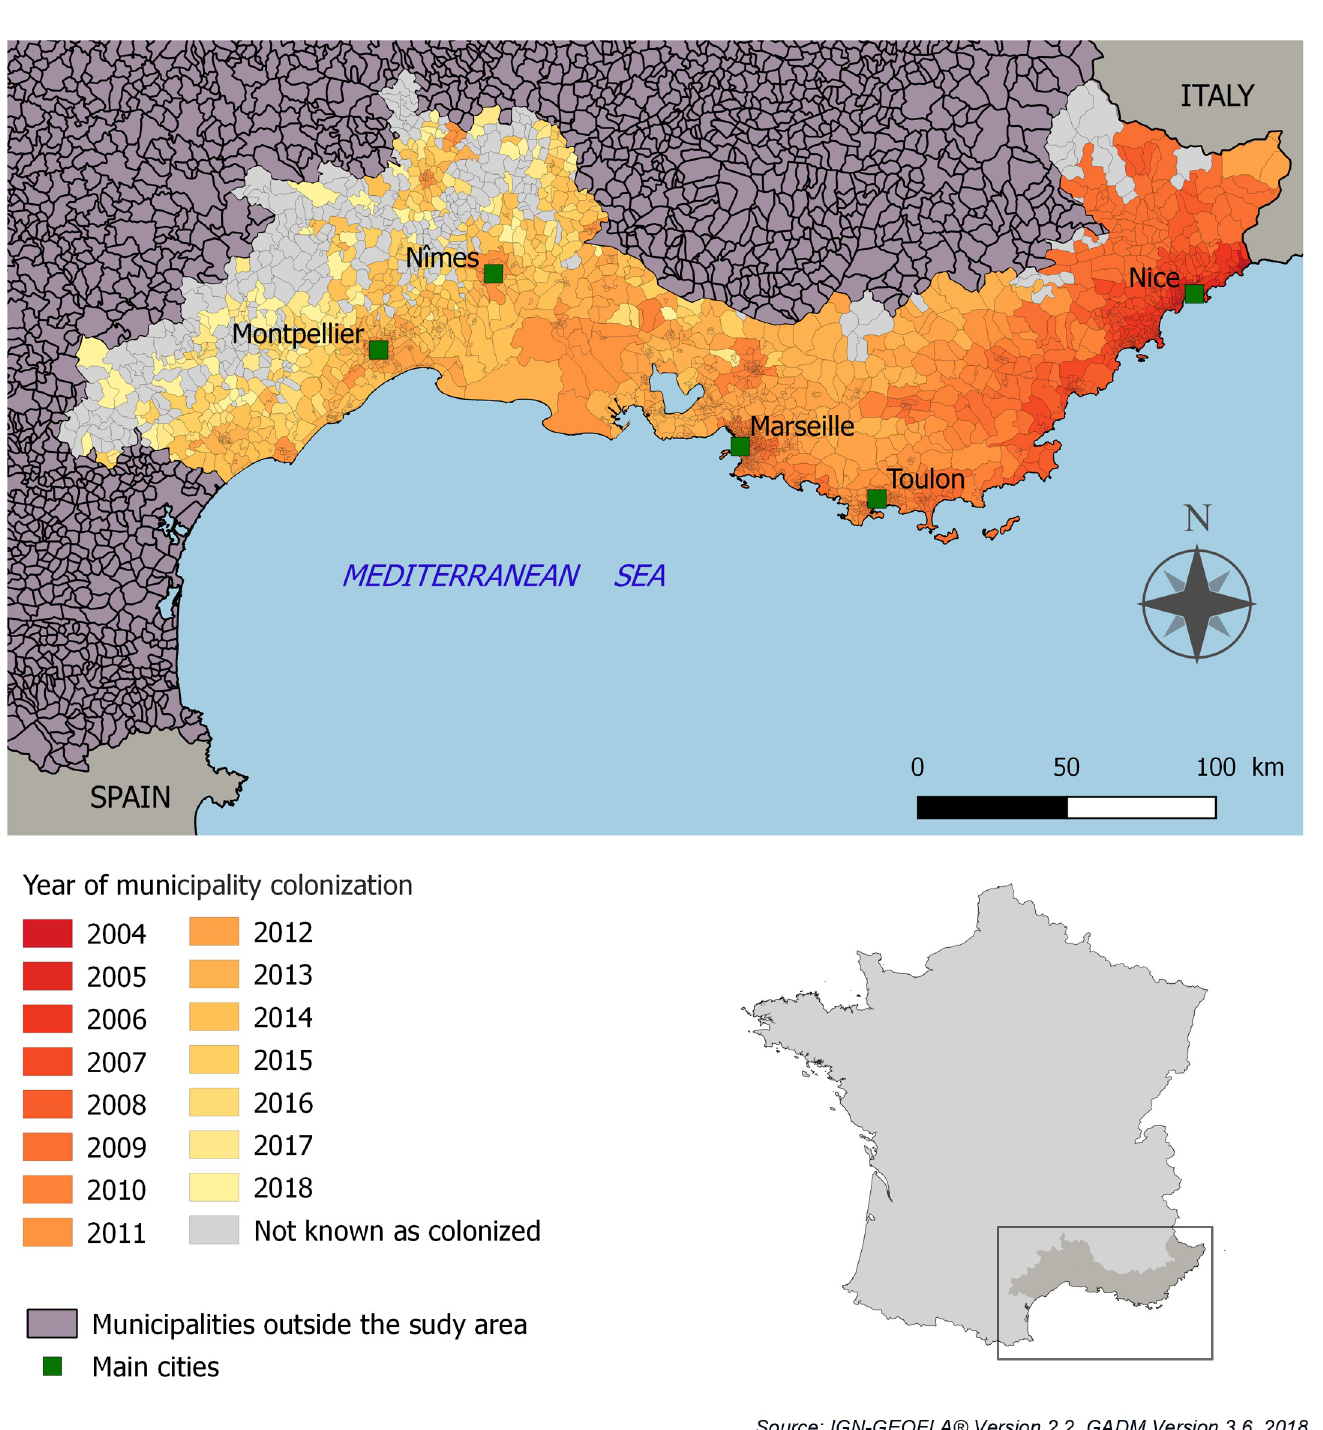
Fig 1. Spatial and temporal distribution of Aedes albopictus in the study area. Source of data: national surveillance of invasive mosquitoes, EID-Me´diterrane´e.